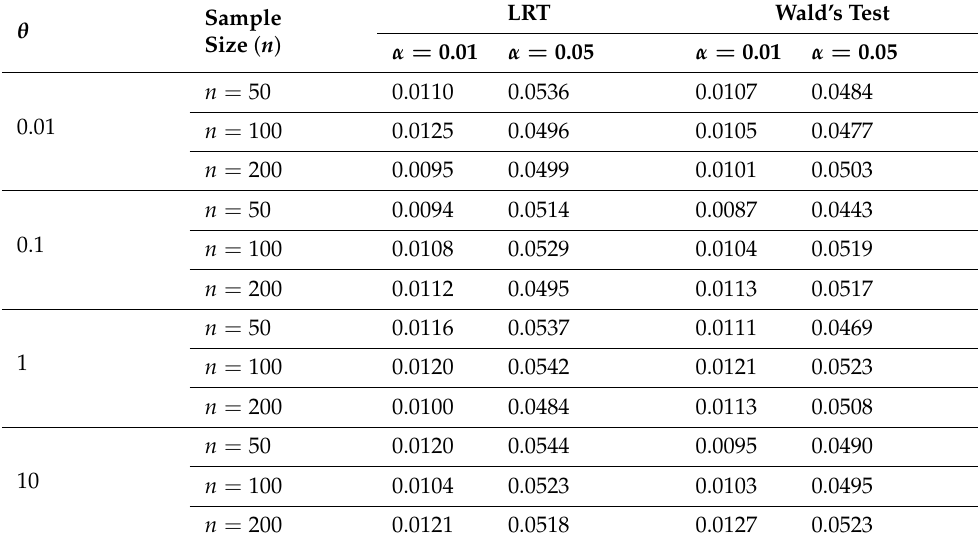
Table 1. Type 1 error rates for likelihood ratio test and asymptotic Wald’s test.